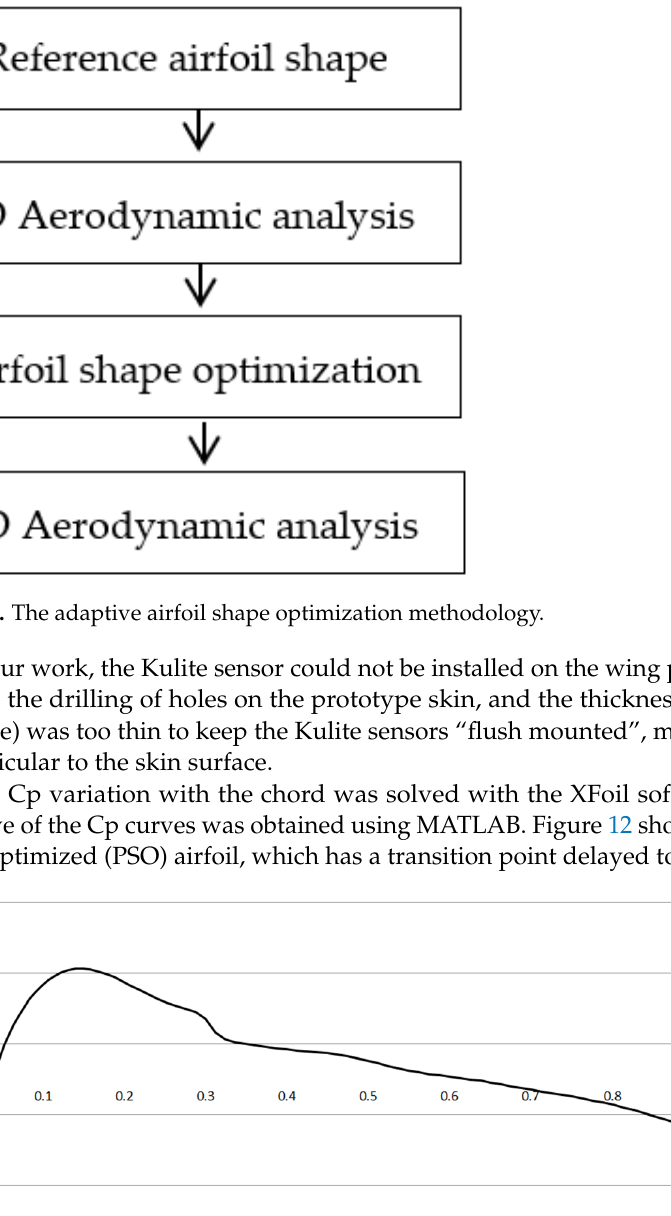
Figure 13. First derivative of the pressure distribution (Cp) of the original (not-optimized) airfoil (short dash line) and the optimized PSO airfoil (solid line). The airfoil shape was optimized for angles of attack between 0 and 5 degrees. The parameters used in these algorithms are the size of the colony, the maximum number of iterations, and the number of variables, with the number of iterations fixed at 500. The aerodynamics conditions are fixed for each airfoil optimization at the cruise al- titude of the UAV S45 (2000 ft) and a flight speed of 30.10 m/s. The objective of the opti- mization is to maximize the fitness function 𝑓 = 𝐶 (cid:3013) 𝐶 (cid:3005) ⁄